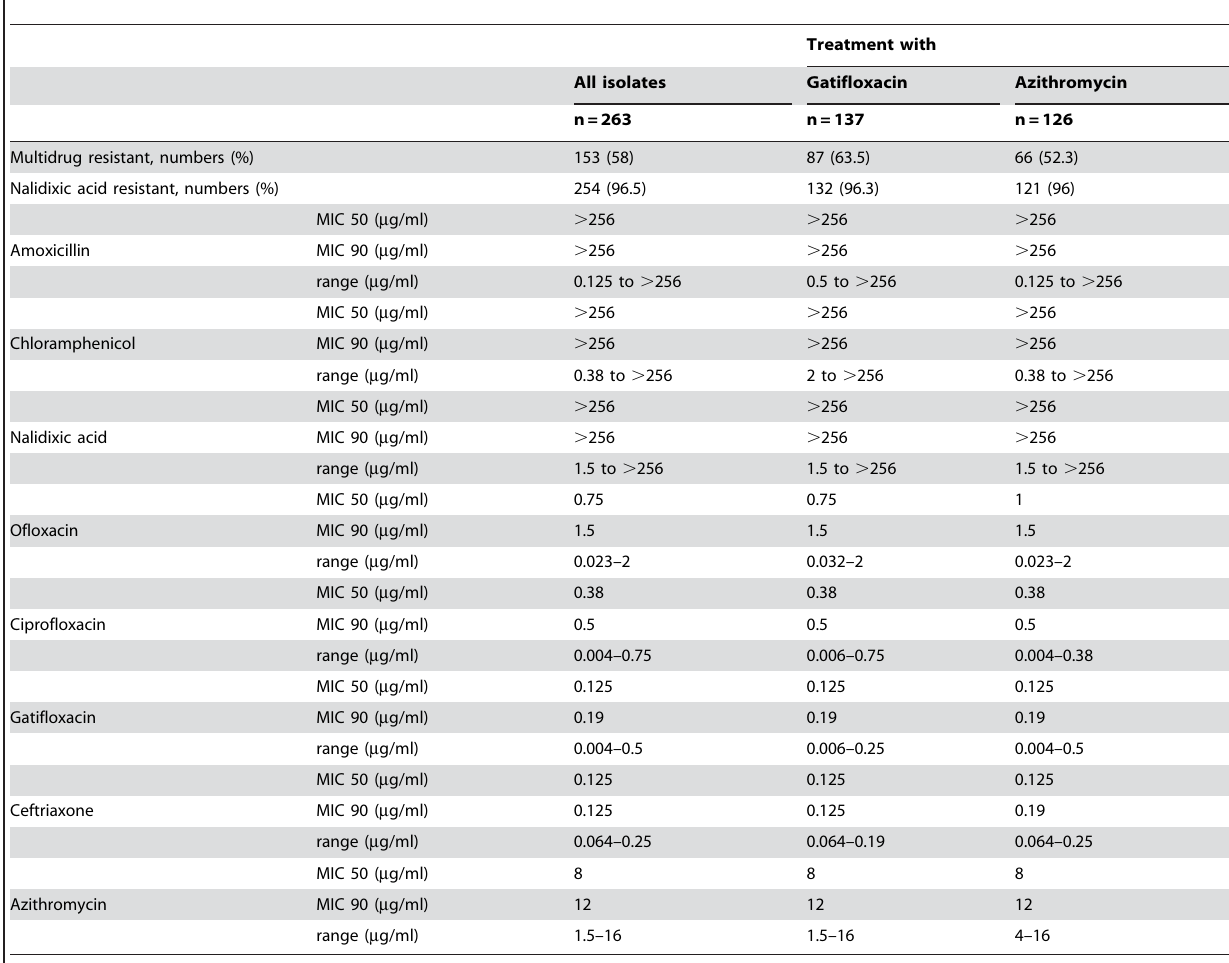
Table 3. Antimicrobial susceptibilities and minimum inhibitory concentrations (MIC) of 263 S. typhi